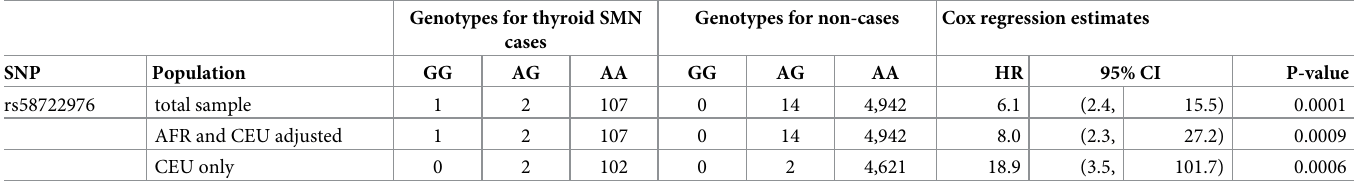
Table 3. Genotype frequencies and Cox regression estimates for POT1 rs58722976 and risk of subsequent malignant neoplasm of the thyroid in the Childhood Can- cer Survivor